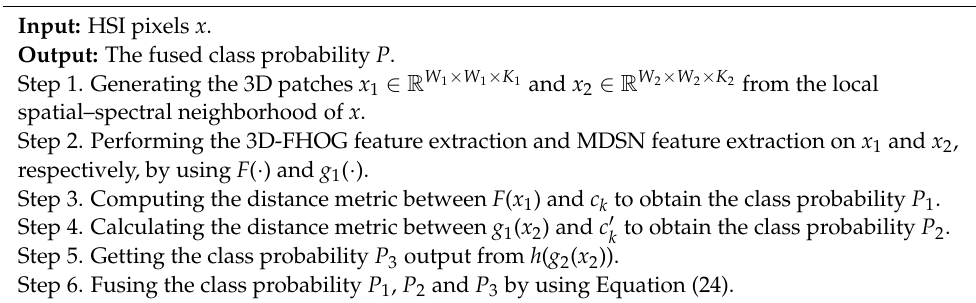
Algorithm 1. MDSN combined with 3D-FHOG for small-sample HSI classification